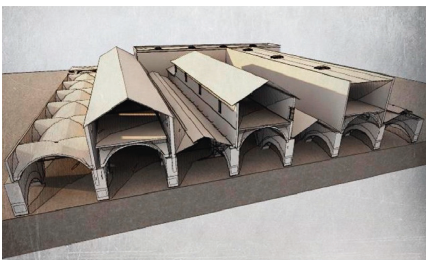
Figure 3: 3D rendering image, sectional drawing, naves 1–7 (left to right), Reales Atarazanas de Sevilla (Seville Royal